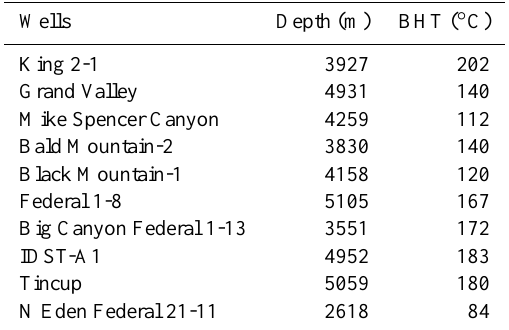
Table 1. Depth and corrected bottom-hole temperatures (BHTs) of several wildcat oil exploration wells in southeastern Idaho (Ral- ston et al., 1981; Souder, 1985; Blackwell et al., 1992; Welhan and Gwynn,